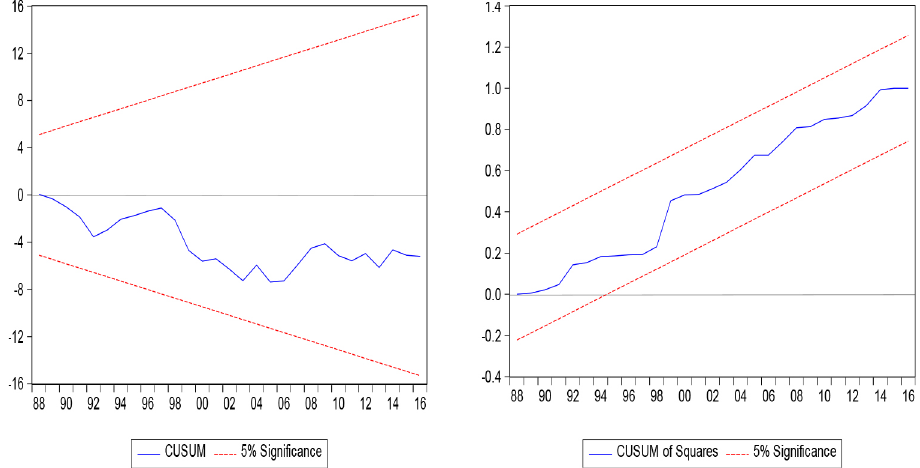
Fig. 3. Cusum and Cusumsq plots for Model 1.